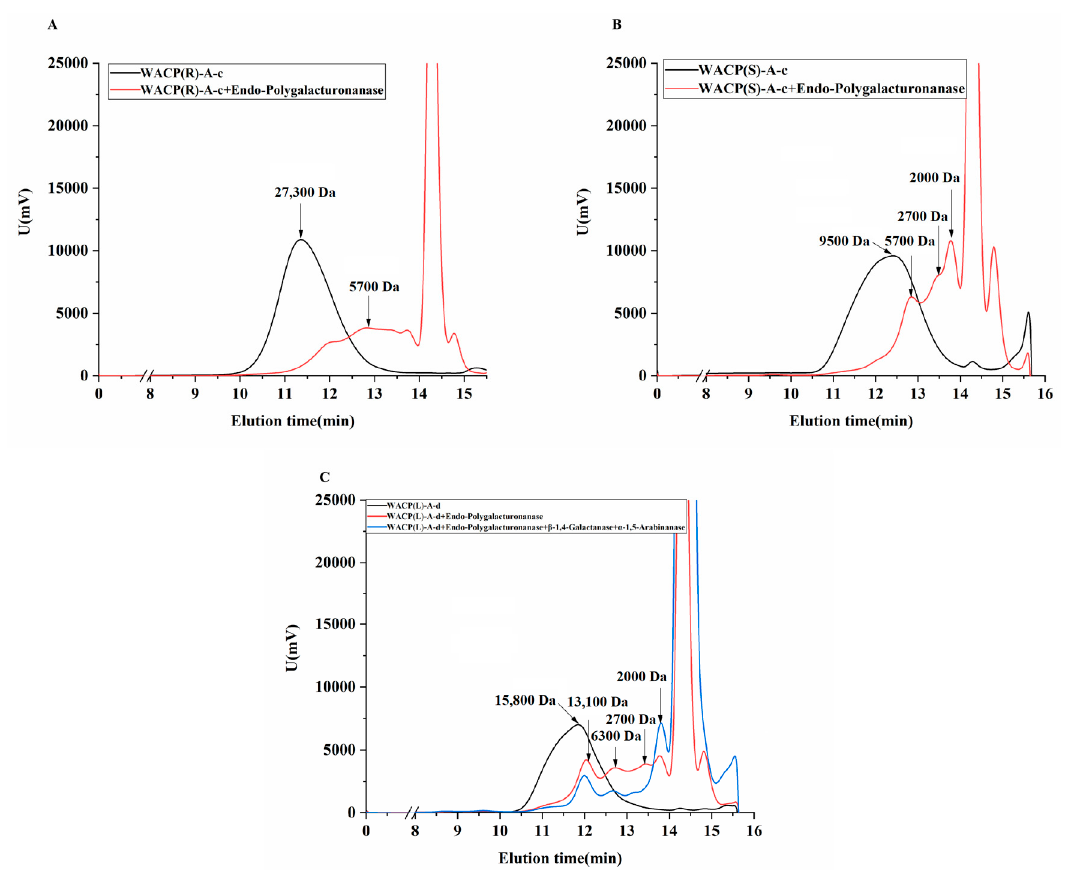
Figure 4. Enzymatic hydrolysis of the polysaccharides and HPGPC analyses.( A: WACP(R)-A-c, B: WACP(S)-A-c, C: WACP(L)-A-d) ( B ): WACP(S)-A-c, ( C ):